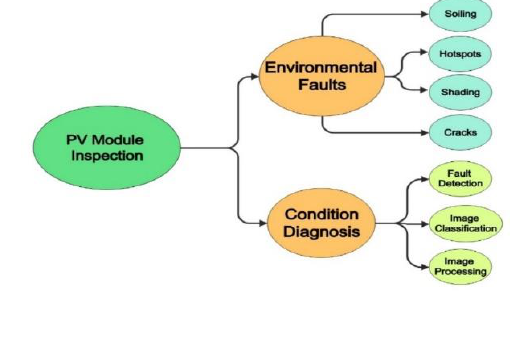
Figure 2. Key concepts of PV Module